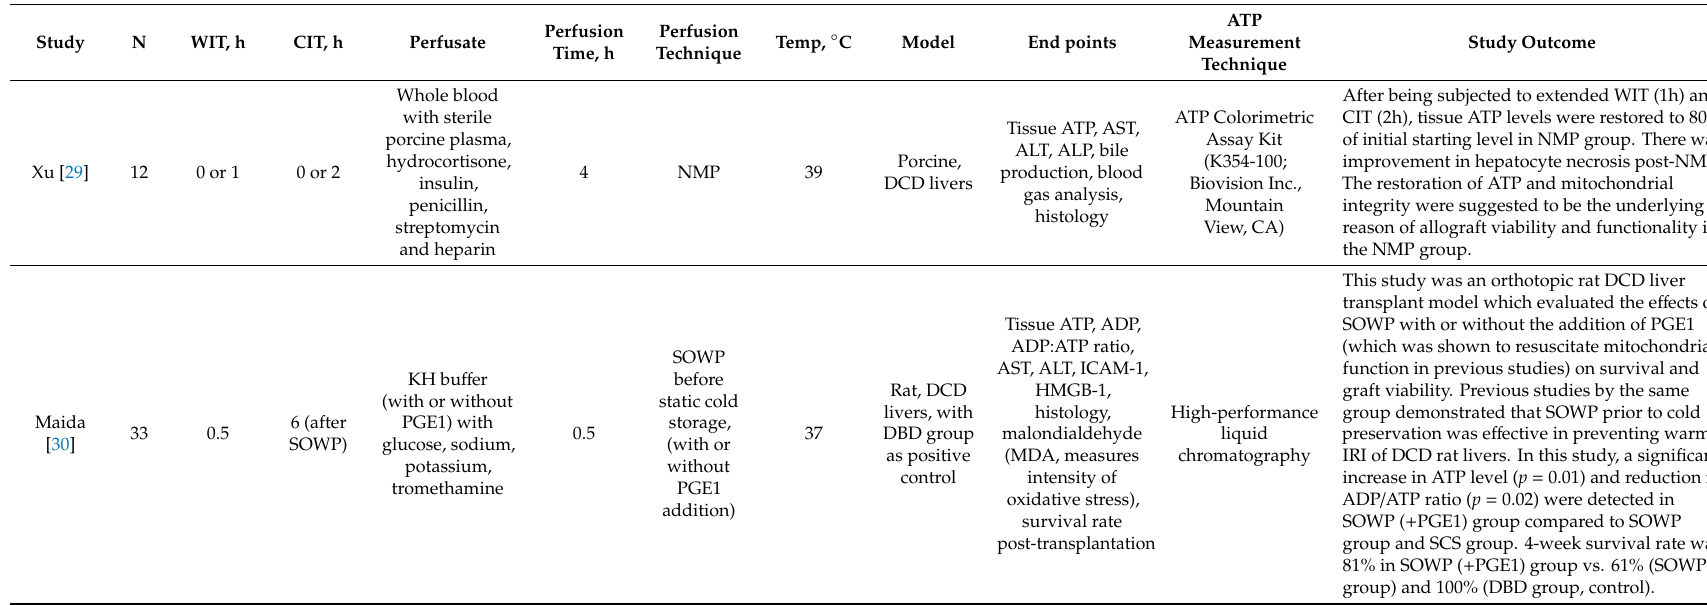
Table 4. Characteristics and outcomes of key pre-clinical and animal studies investigating NMP preservation of